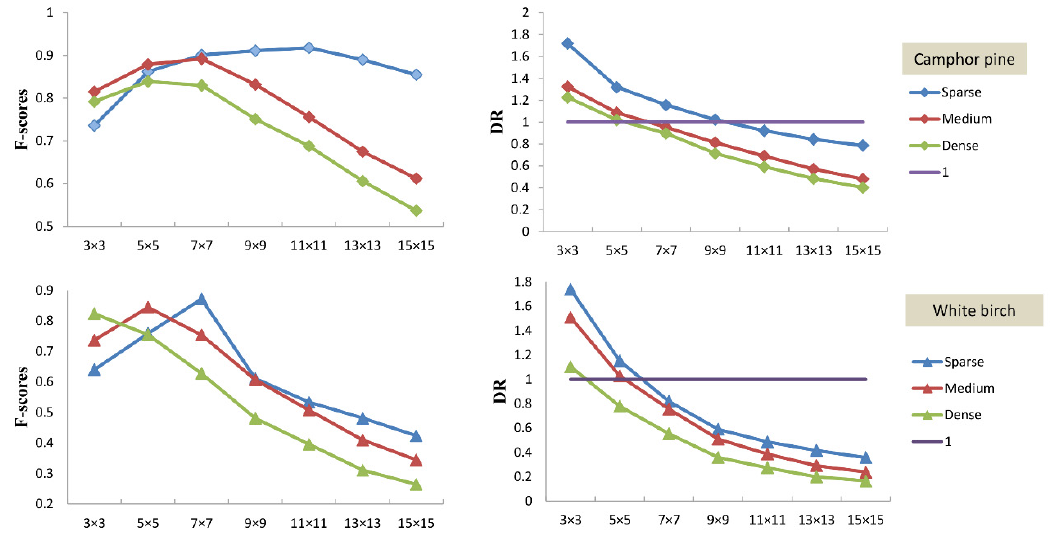
Figure 7. Treetop-detection accuracy in various cases. X axes refers to various treetop-detection-window sizes; y axes refer to F-scores or DR, where F-scores refer to the overall accuracy of treetop detection based on the local maximum method. The higher the value of F-scores, the higher the accuracy of treetops detected. DR denotes the detection rate, values of which close to 1 indicted a superior the treetops detected effect.